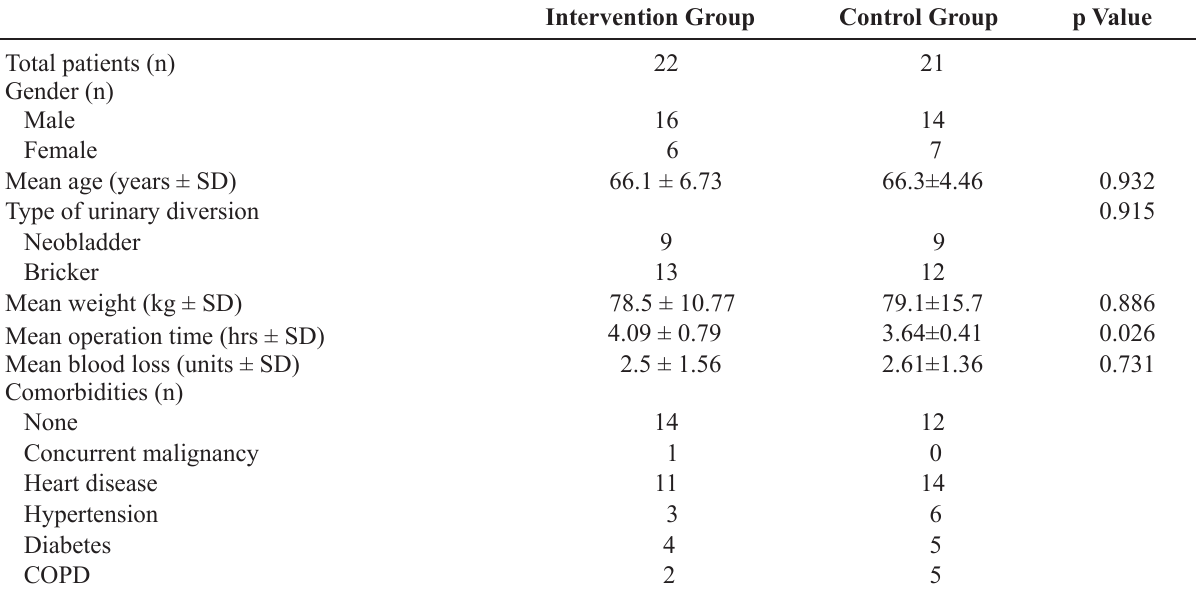
COPD = chronic obstructive pulmonary disease; SD = standard